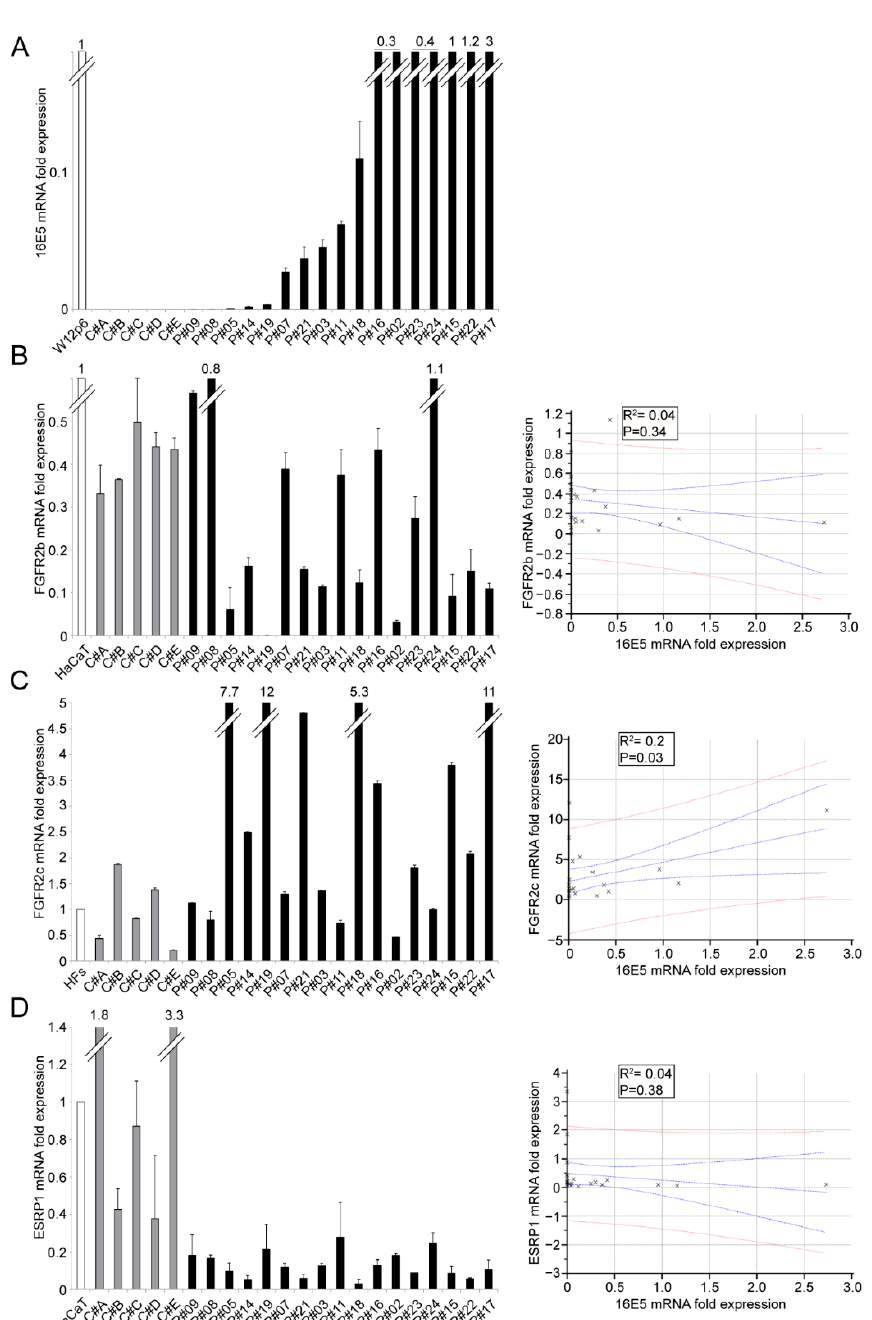
Figure 1. Expression of HPV16E5, FGFR2 isoforms and ESRP1 in LSILs: 16E5 ( A ), FGFR2b ( B ), FGFR2c ( C ) and ESRP1 ( D ) mRNA levels were evaluated by real-time PCR in LSILs and normalized with respect to W12p6 cells, HaCaT cells or HFs, as reported in the graph. Results are expressed as the mean ± SD from three independent experiments in triplicates. The relationships between the variables are expressed in the scatter diagrams in which HPV16E5 expression levels are plotted on the horizontal axis and the FGFR2b, FGFR2c and ESPRP1 expression levels are plotted on the vertical axis. The regression line ±95% confidence limits are shown in blue, and the ±95% prediction bands are in red. R 2 : Pearson’s correlation coefficient value.